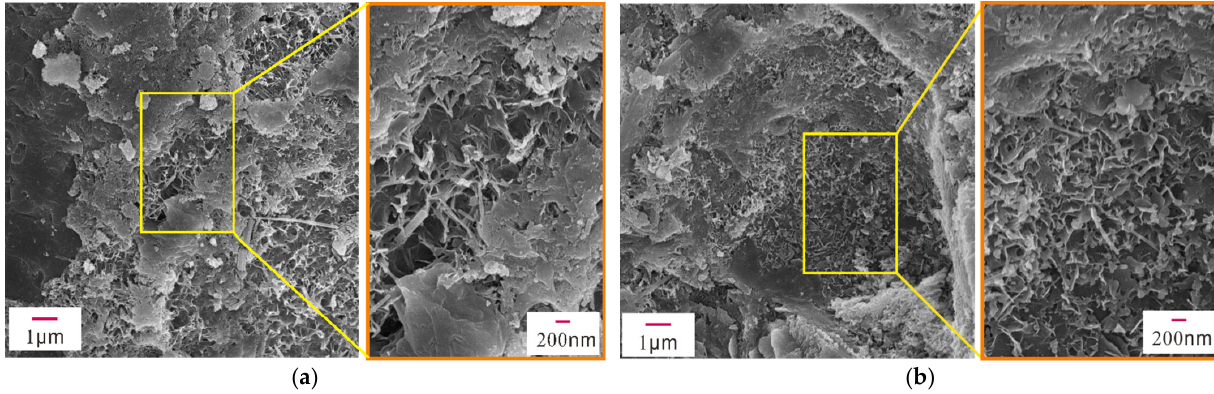
Figure 5. SEM images of sample Q. ( a ) Partial SEM image of sample Q, ( b ) Partial SEM image of sample Q.